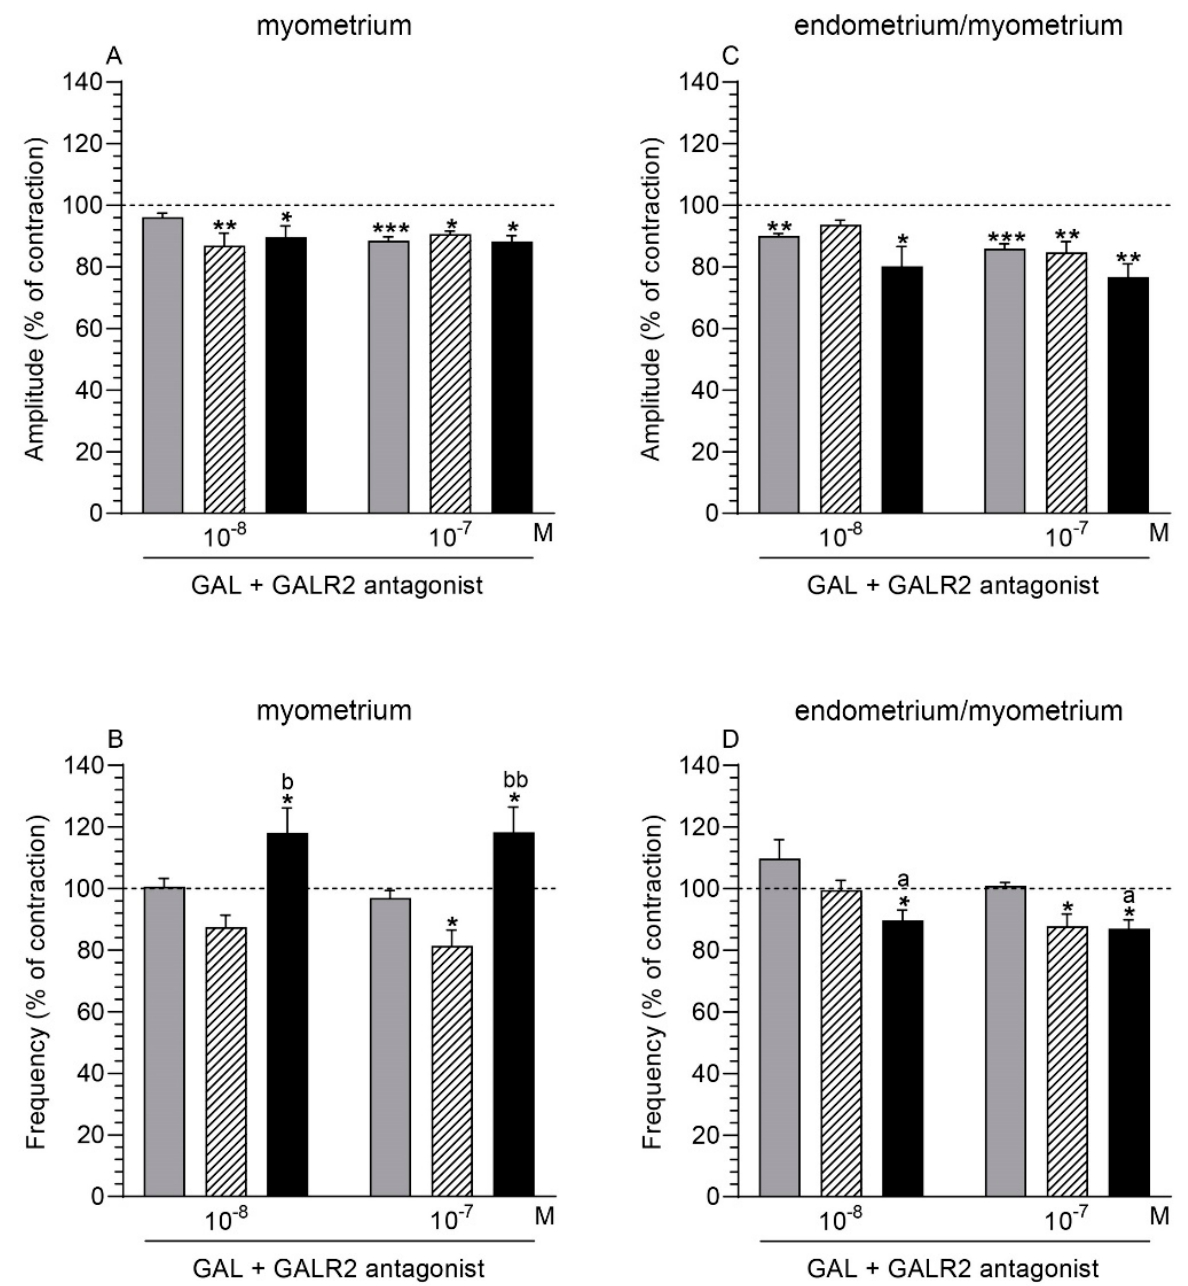
Figure 4. The influence of galanin (GAL) on the contractile amplitude ( A , C ) and frequency ( B , D ) in the myometrium ( A , B ) and endometrium/myometrium ( C , D ) stripes of gilts from the CON (grey bars), SAL (hatched bars), and E. coli (black bars) groups after using GALR2 antagonist (at a dose of 10 − 6 M). Results were calculated for five gilts in each group. The effects of antagonist and individual GAL doses are depicted as percentages (mean ± SEM) of the baseline (pretreatment period) contractile amplitude and frequency, taken as 100% (horizontal lines). * p < 0.05, ** p < 0.01, *** p < 0.001 compared to the basal value in each group; a p < 0.05 compared between the CON and E. coli groups for the same treatment; b p < 0.05, bb p < 0.01 compared between the SAL and E. coli groups for the same